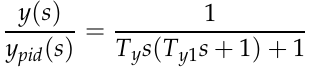
Figure 3. ac servo motor/ electro-hydraulic actuator type servo system.